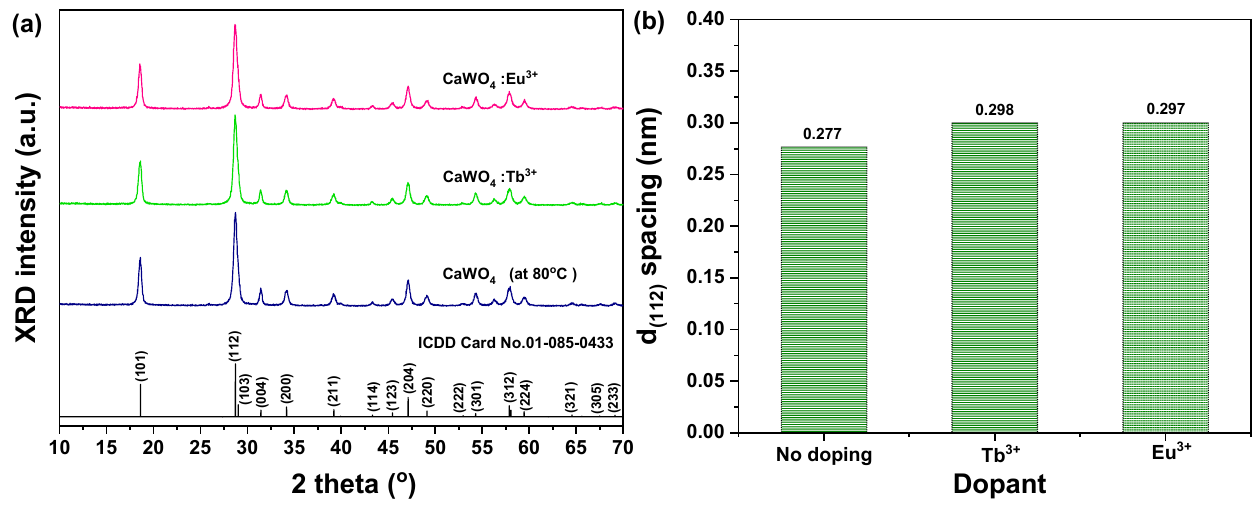
Figure 2. ( a ) XRD patterns and ( b ) change in d (112) spacing; CaWO 4 , CaWO 4 :Tb 3+ , and CaWO 4 :Eu 3+ . In addition, the size of each sample particle was investigated by substituting the half width and peak position of the main peak (112) in Scherrer’s equation [22]. CaWO 4 The size and surface morphology of the synthesized crystalline CaWO 4 , CaWO 4 :Tb 3+ , samples were calculated at 76 nm, CaWO 4 :Tb 3+ at 85 nm, and CaWO 4 :Eu 3+ at 90